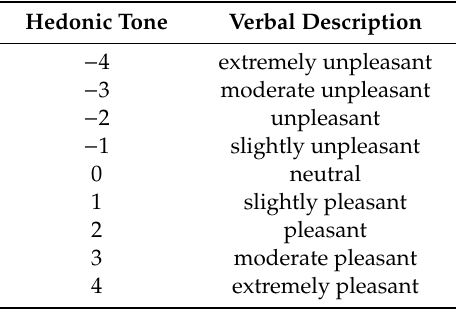
Table 1. The 9-point hedonic scale for